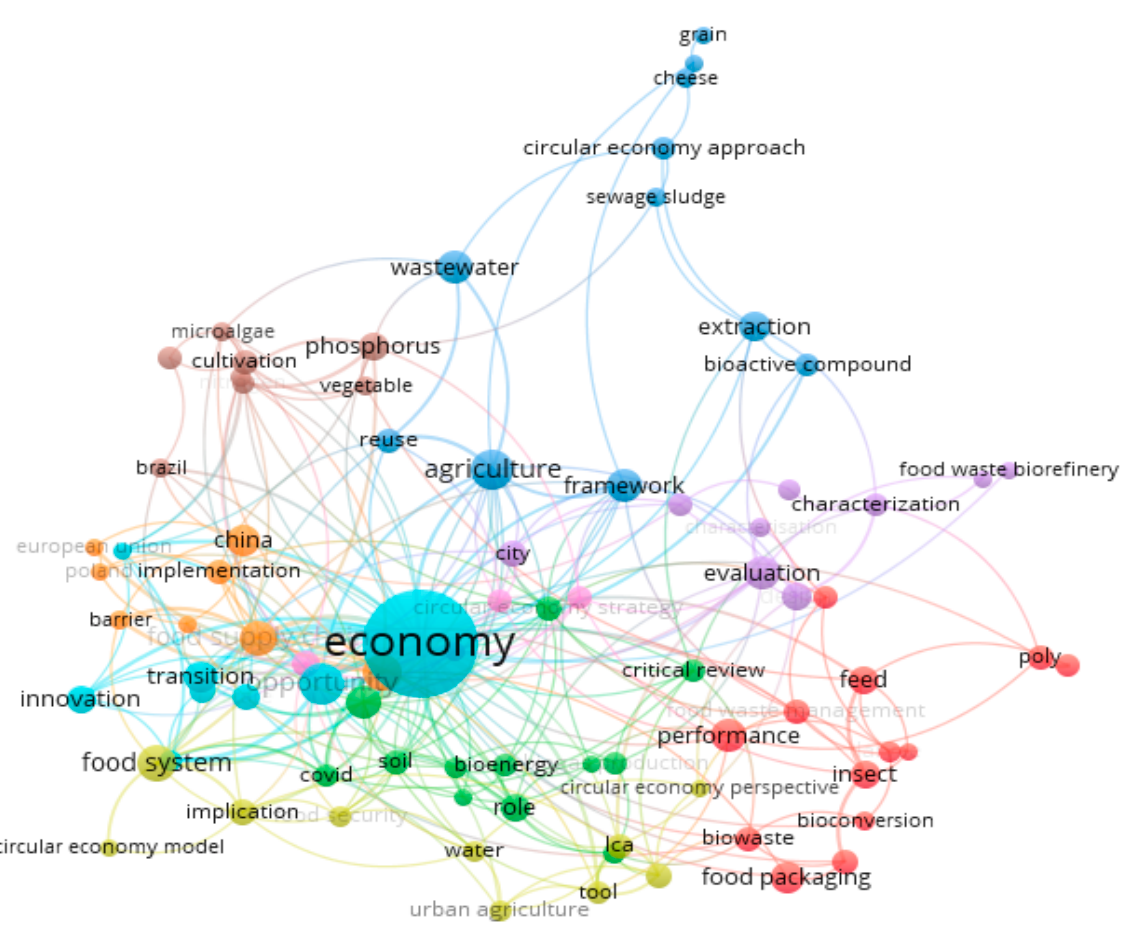
Figure 4. Top keywords co-occurrence network on circular economy and food during 2012–2021. Source: Authors’ elaboration.